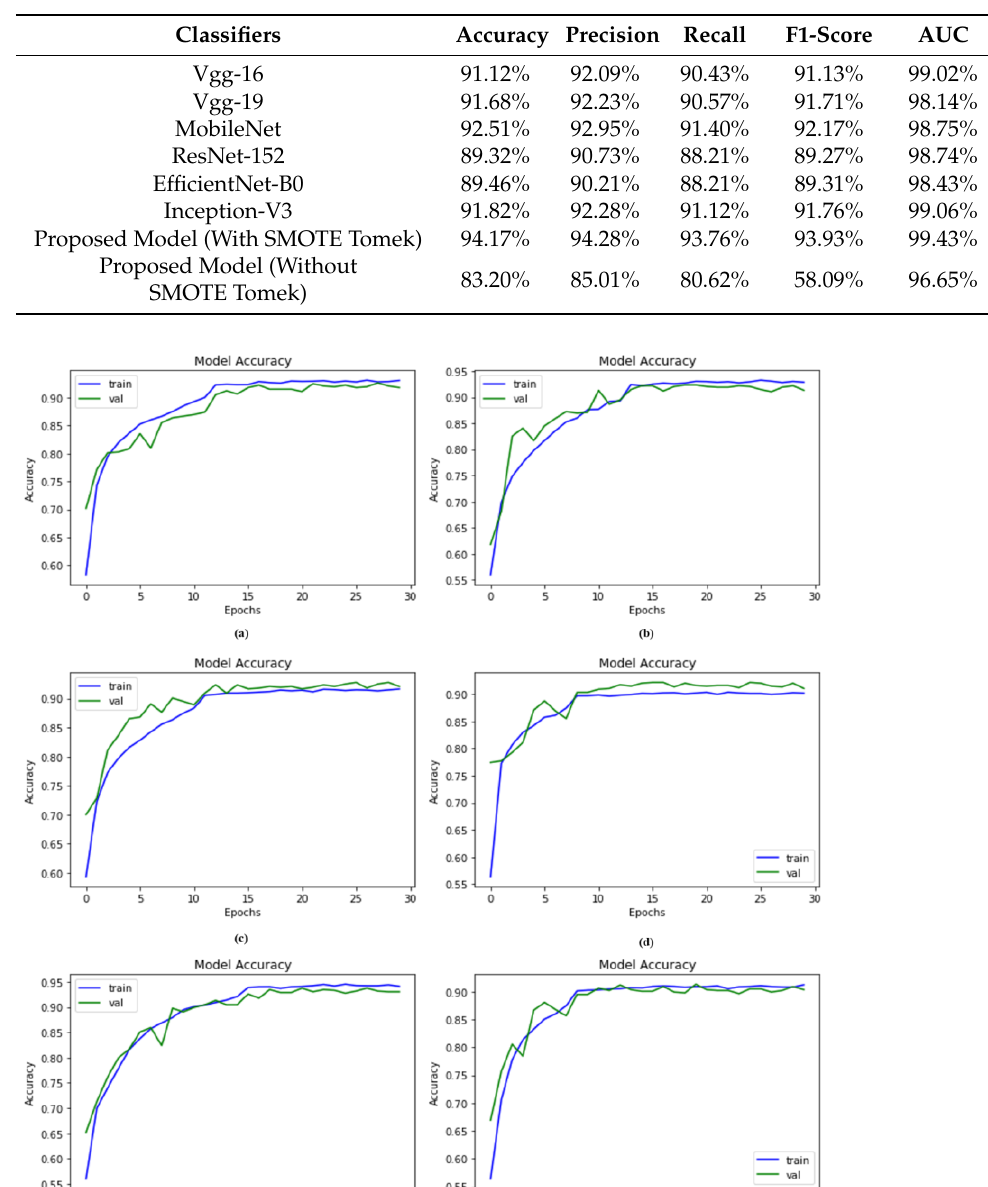
Table 5. Performance of the DSCC_Net model compared with baseline algorithms.